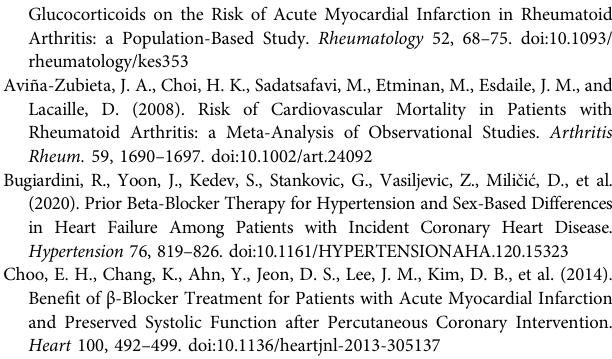
Supplementary Figure 1 | Plots of the scaled Schoenfeld residuals versus time for the Cox proportional hazards model fi t to the entire dataset. The solid line gives the estimated effect of the predictors through time. Plots are given for (A) beta-blockers versus control, (B) non-selective beta-blockers versus control, (C) β 1-selective beta-blockers versus control and (D) non-selective versus β 1-selective beta- blockers. Abbreviations: BB,